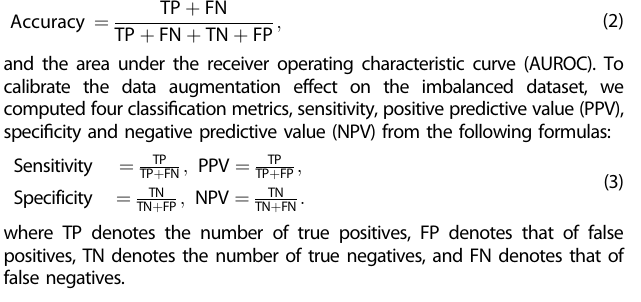
Fig. 8 Neural network architectures, transfer-learning methods, and data preprocessing. a The general structure of the neural networks implemented, consisting of a feature block and a FNN block. The unit in the feature block is model-speci fi c, for example, when referring to the RNN model, the units are GRUs. b Transfer-learning methods implemented, where colored blocks represent reusing neural network parameters (weights and biases) inherited from the pre-training step, the null-colored block in Transfer3 represents re-initializing the network parameters of the FNN block. Blocks bounded with solid lines represent those blocks, of which the network parameters are frozen during retraining step. c – e Representations of each unit used in different types of neural networks. c A gated recurrent unit (GRU) used in the RNN models. d A convolutional sequence to sequence (conv seq2seq) unit used in the CNN models. e A self-attention unit used in the SAN models. More details of transfer learning can be found in Table 3. f Data pre-processing methods employed to deal with data imbalance, the minority data (sequences with hypoglycemia labels) are oversampled to increase model sensitivity for hypoglycemia detection. Output BG values greater then 80 mg/dL are labeled with “ no hypoglycemia ” (NO HYPO) and those smaller than 80 mg/dL are labeled with “ hypoglycemia ”